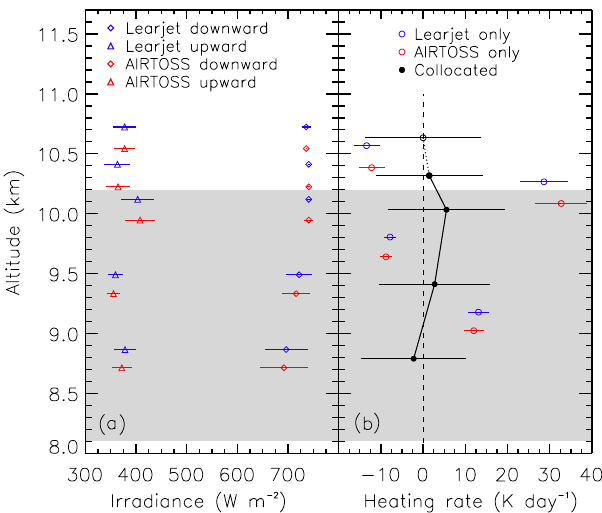
Figure 9. (a) Profiles of vertical upward and downward broadband irradiance measured on AIRTOSS and the Learjet. The bars indicate the standard deviation of the irradiance along the individual flight legs. (b) Solar heating rates calculated from the irradiance profile using either a single platform or the collocated measurements. The grey area indicates the cirrus layer as indicated by the